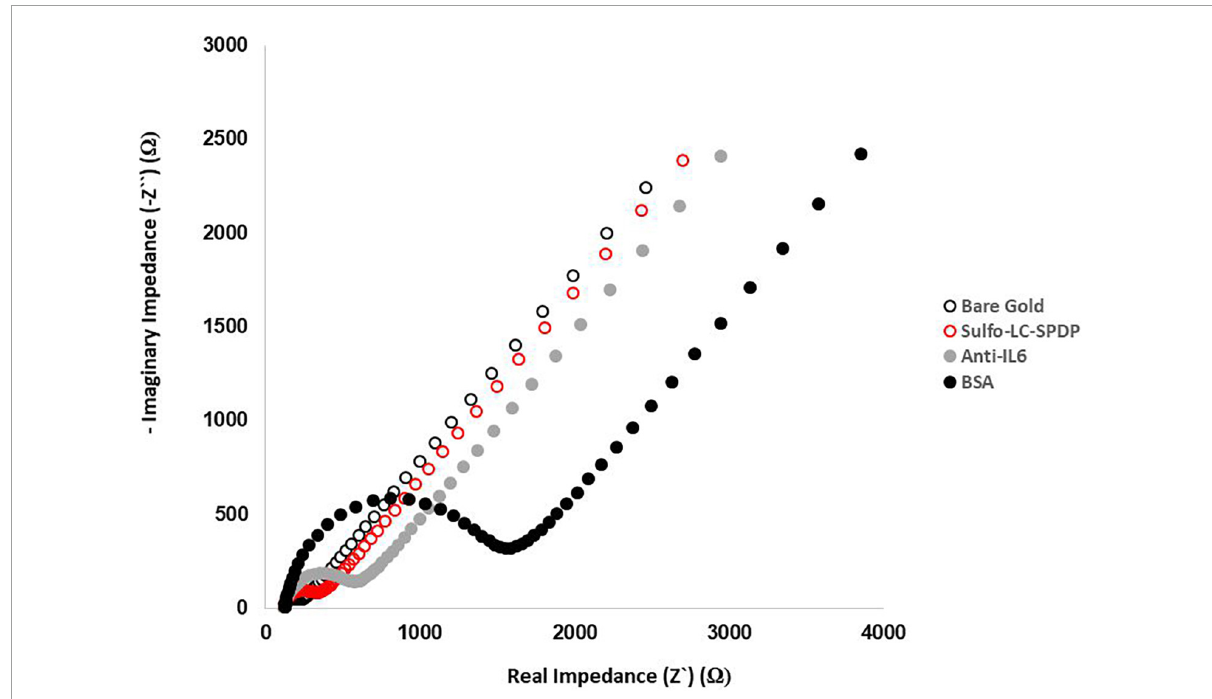
FIGURE2 Evaluation of the functionalization steps by EIS. Nyquist plots of the functionalization process were obtained in 5.0 mM [Fe(CN)6] 3 − / 4 − PBS buffer pH 7.4 using a sinusoidal potential perturbation of 5 mV over a frequency range of 1 × 10 5 − 0.1 Hz.